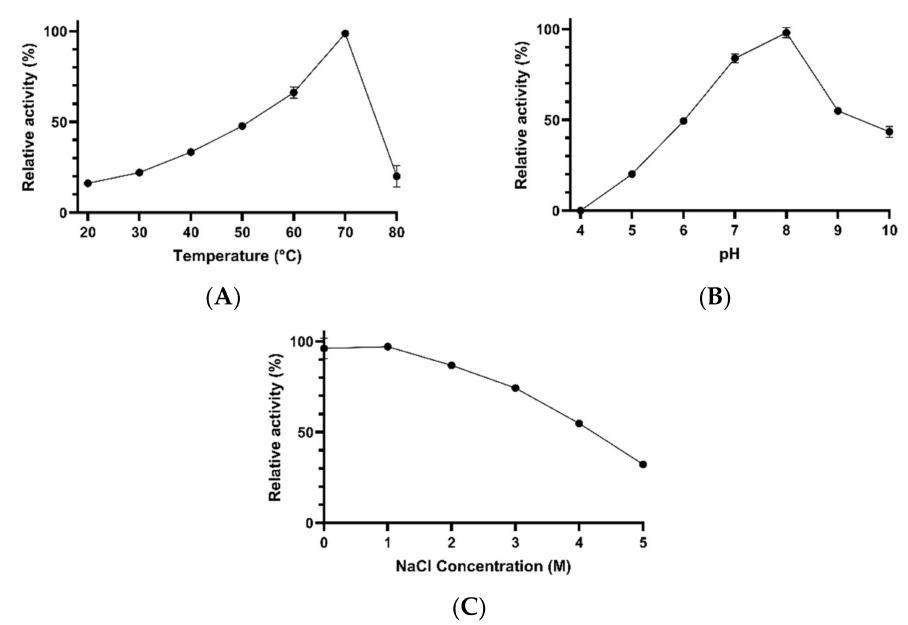
Figure 9. The effects of temperature ( A ), pH ( B ) and NaCl concentration ( C ) on the activity of concentrated xylanases obtained from Bacillus sp. BA N P1.4 Error bars represent the standard deviation of the mean ( n =